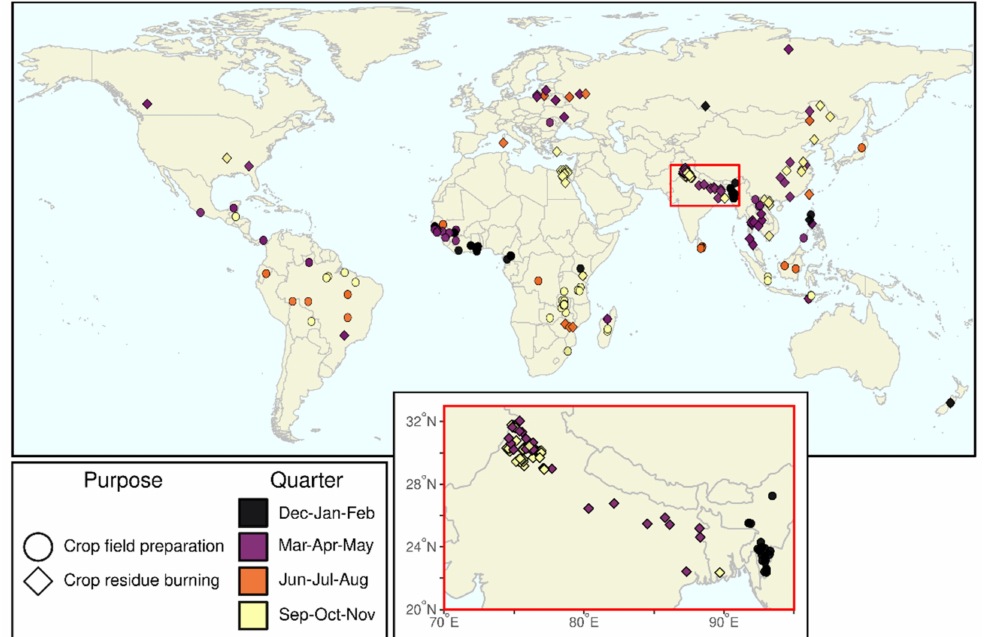
Figure 6. Spatial distribution of DAFI ‘fire season start’ data for cropland fire practices. Start months are grouped by year